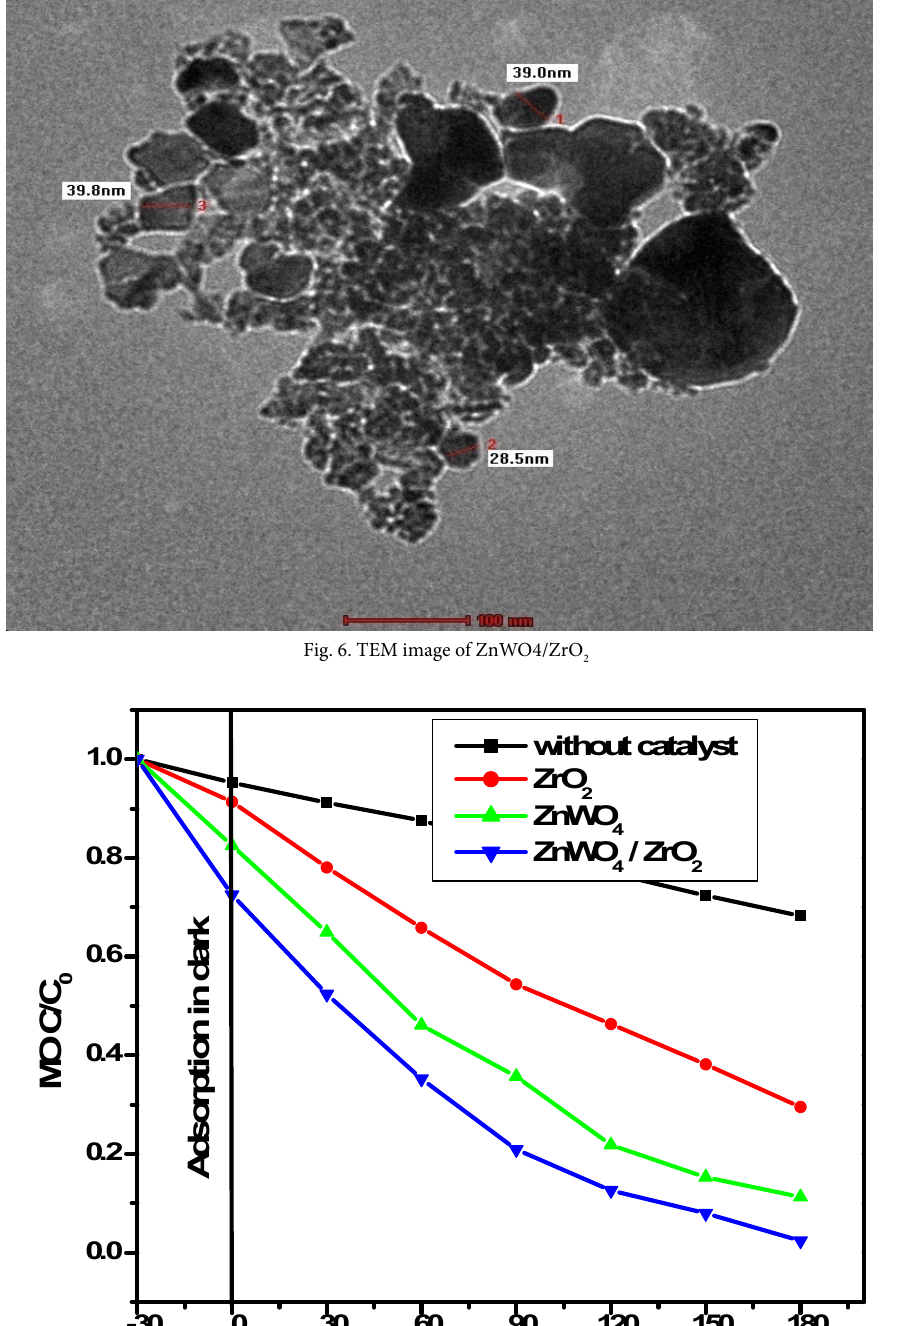
, ZnWO and ZnWO /ZrO 2 4, 4